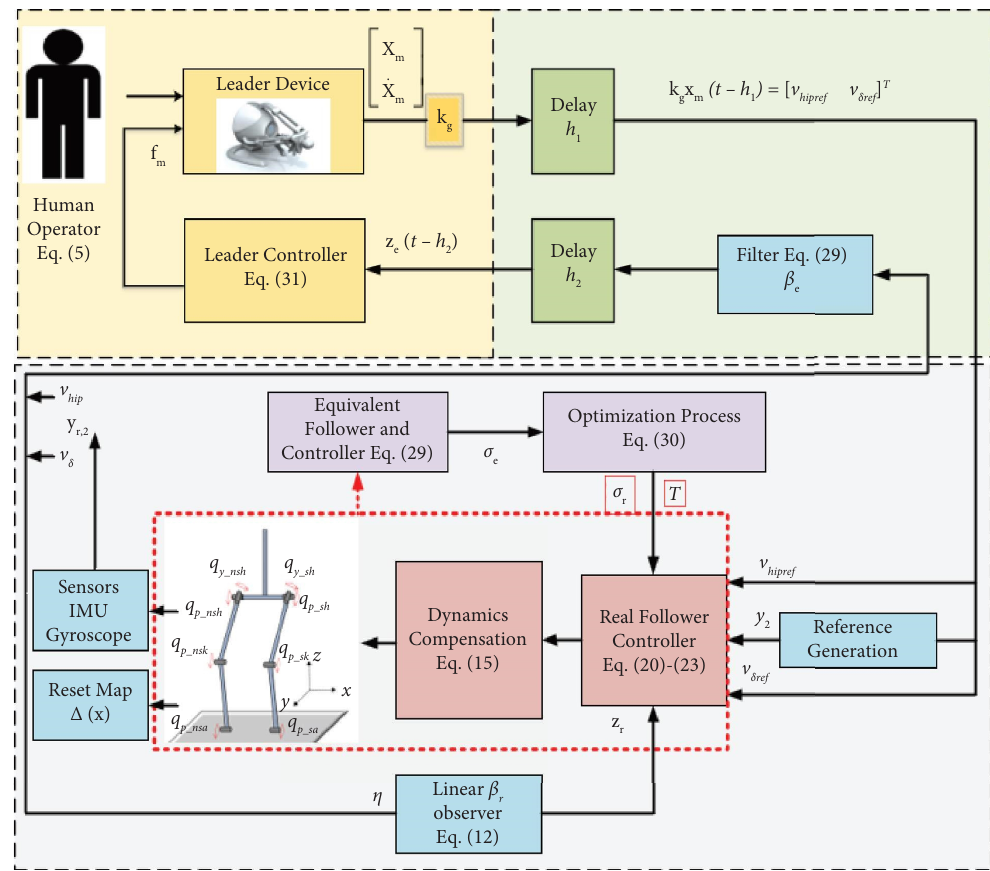
Figure 4: Complete control scheme: leader controller, time delays, and remote